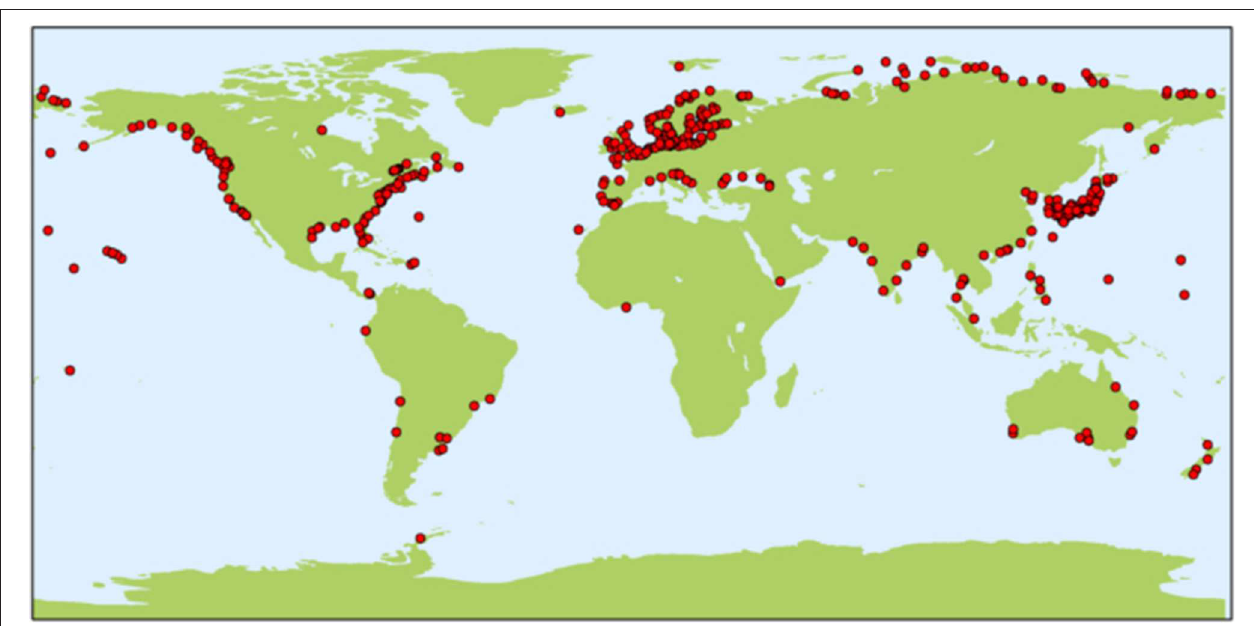
FIGURE 1 | Tide gauge coverage with > 40-year-long records (source: PSMSL; https://www.psmsl.org/products/data_coverage/).